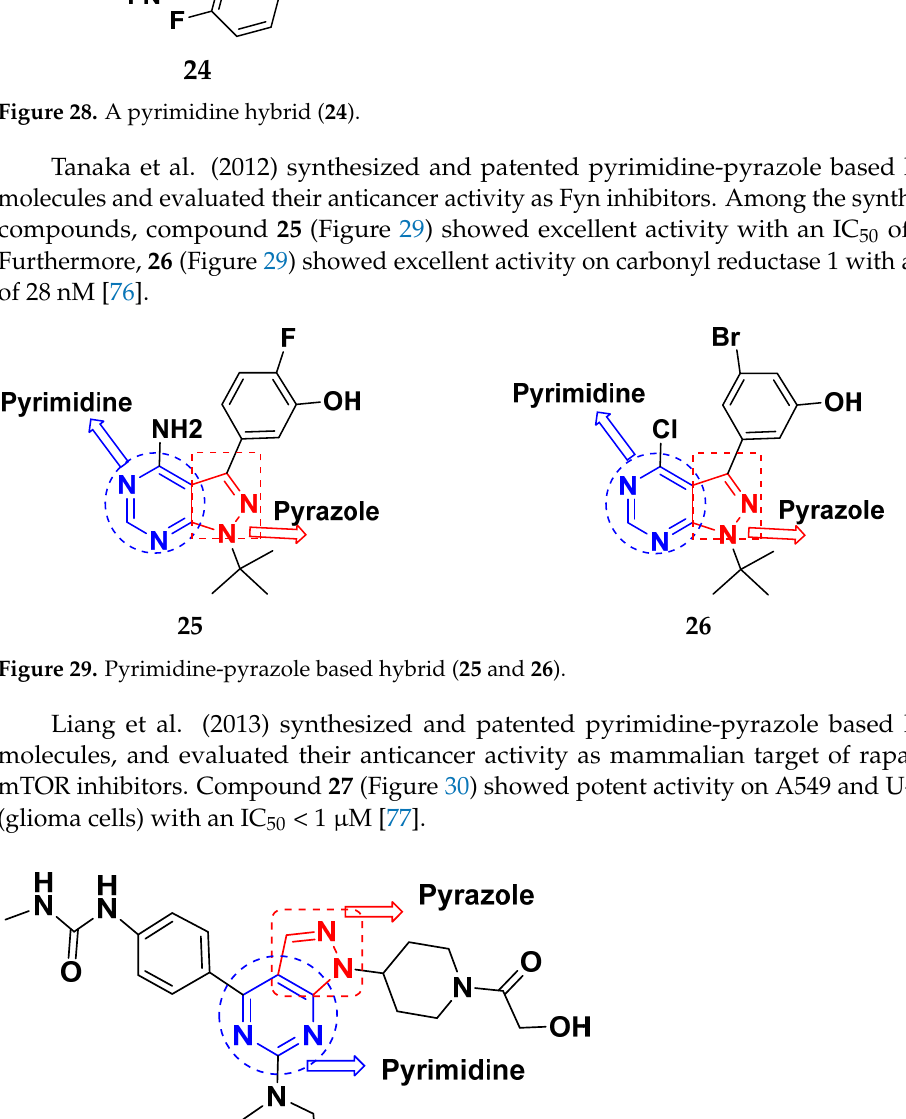
Figure 28. A pyrimidine hybrid ( 24 ).